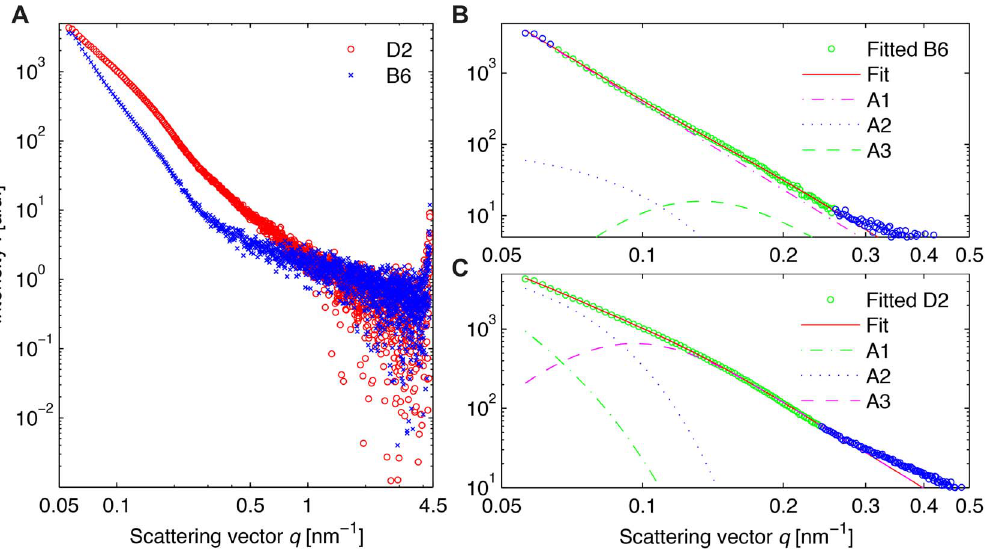
Figure 1. SAXS data for suspended melanosomes from C57BL/6J (B6) and DBA/2J (D2) mice. Melanosomes were exposed to photons at E =12.8 keV for 10 s. (A) Comparison of scattering intensities for both phenotypes, in the range of 0.05 to 4.5 nm 2 1 . (B) Analysis of B6 melanosome structure by fitting a model of independent scatterers to the q -interval 0.07 nm 2 1 , q , 0.27 nm 2 1 . The resulting fitting parameters in the power law are p 1 =4.034 6 0.001 (small q -values), p 2 =3.887 6 0.118 (high q -values) und R B6 =22.57 6 5.57 nm (radius of gyration of melanosomal subunits). (C) Analysis of D2 melanosome structure by fitting a model of dependent scatterers to data within the q -interval 0.05 nm 2 1 , q , 0.27 nm 2 1 . The determined parameters are p 1 =2.56 (modified power law at small q -values), p 2 =3.60 (power law at high q -values) and R D2 =31.32 6 1.71 nm (radius of gyration of melanosomal subunits). In (B) and (C) the terms that contribute to the fit model used are labeled A1, A2 and A3. The analyzed data points are shown in green.